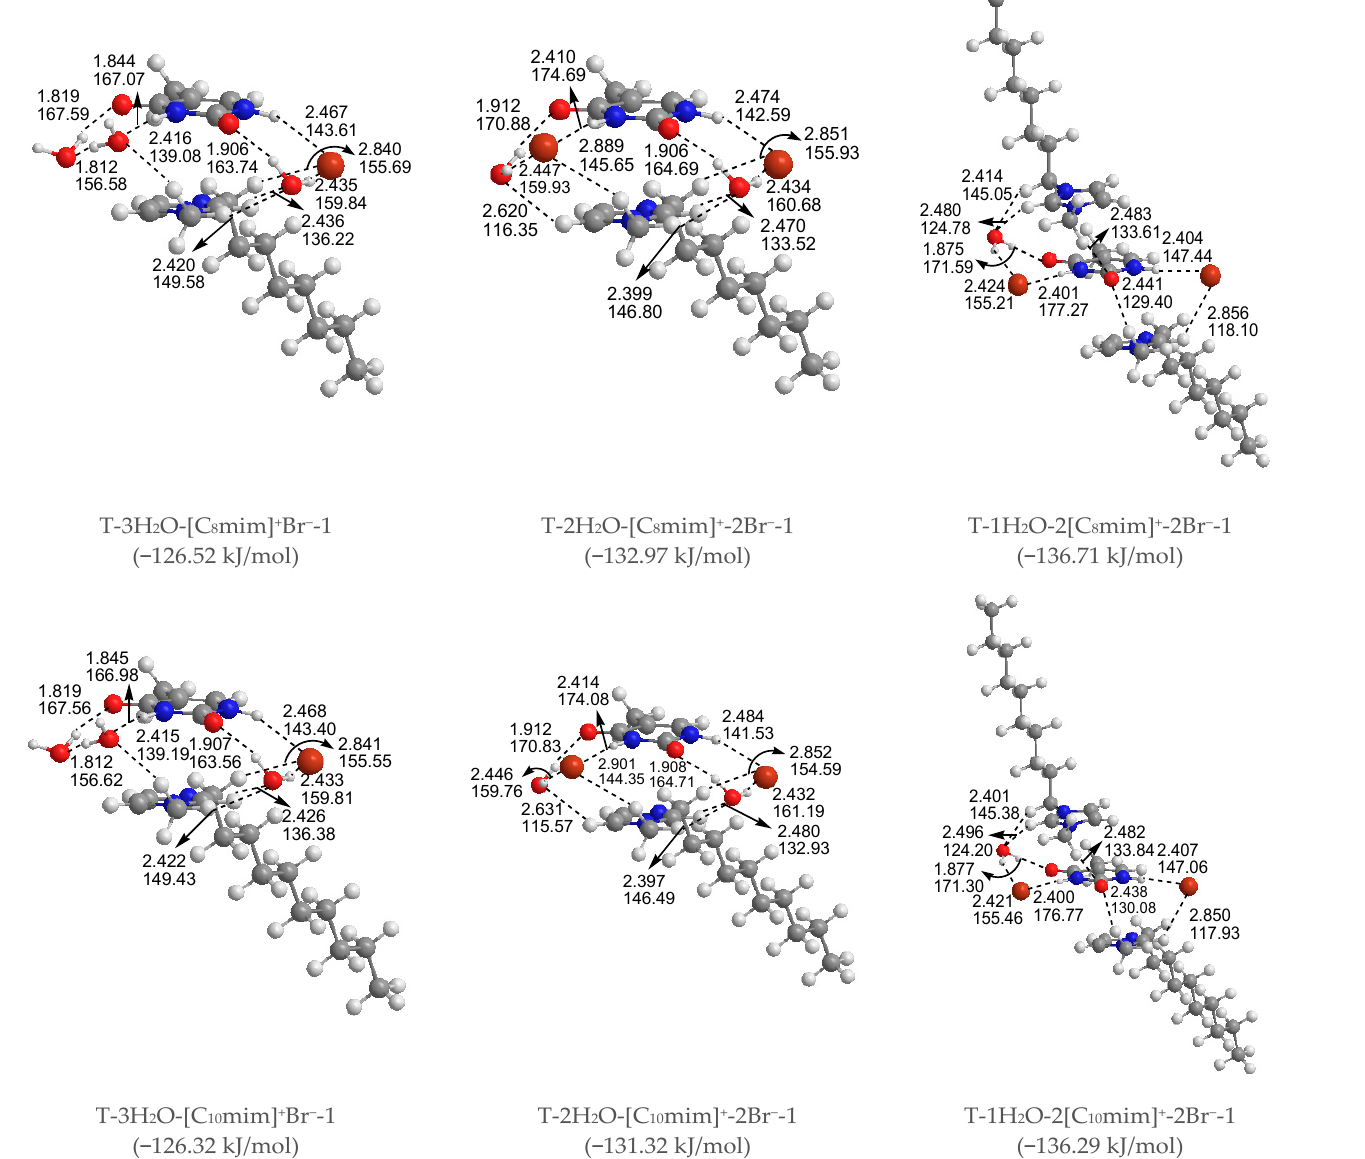
Figure 3. The most stable structures for the free-, mono -, di -, tri -, and tetra -ionic microhydrates, T-5H 2 O-1, T-4H 2 O-Br − -1, T-3H 2 O-[C n mim] + -Br − -1, T-2H 2 O-[C n mim] + -2Br − -1, and T-1H 2 O-2[C n mim] + - 2Br − -1 ( n = 2, 4, 6, 8, 10). The bond length in Å, H-bond angle in °, the binding energy listed in parentheses. Ionic T-wH 2 O-y[C n mim] + -xBr − -k microhydrates. Mono-ionic T - w 1 H 2 O-Br − hydrates (w 1 = 1, 2, 3, 4) . In comparison, the T- w 0 H 2